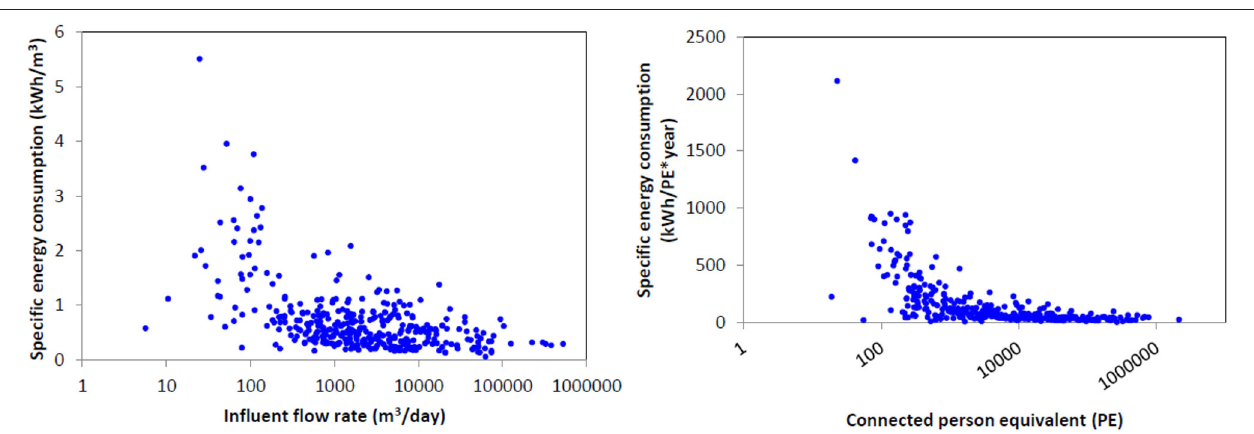
FIGURE 5 | Correlation between PE/ inlet flow rate and specific energy consumption (Horizon2020 ENERWATER Project,